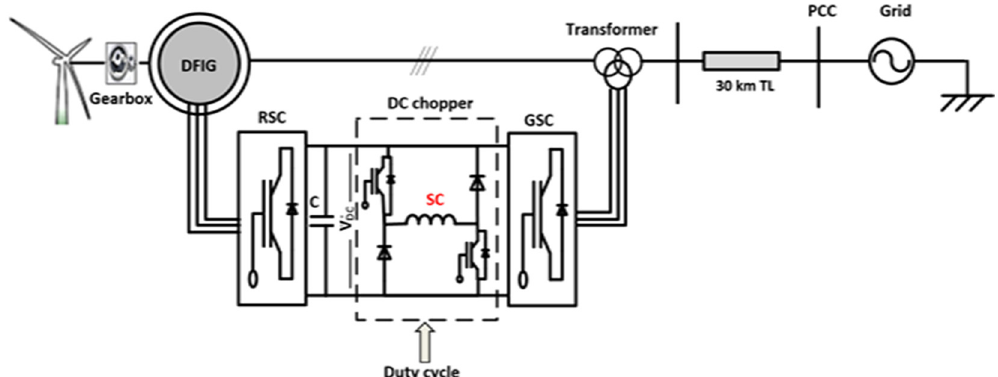
Figure 1. System under study.